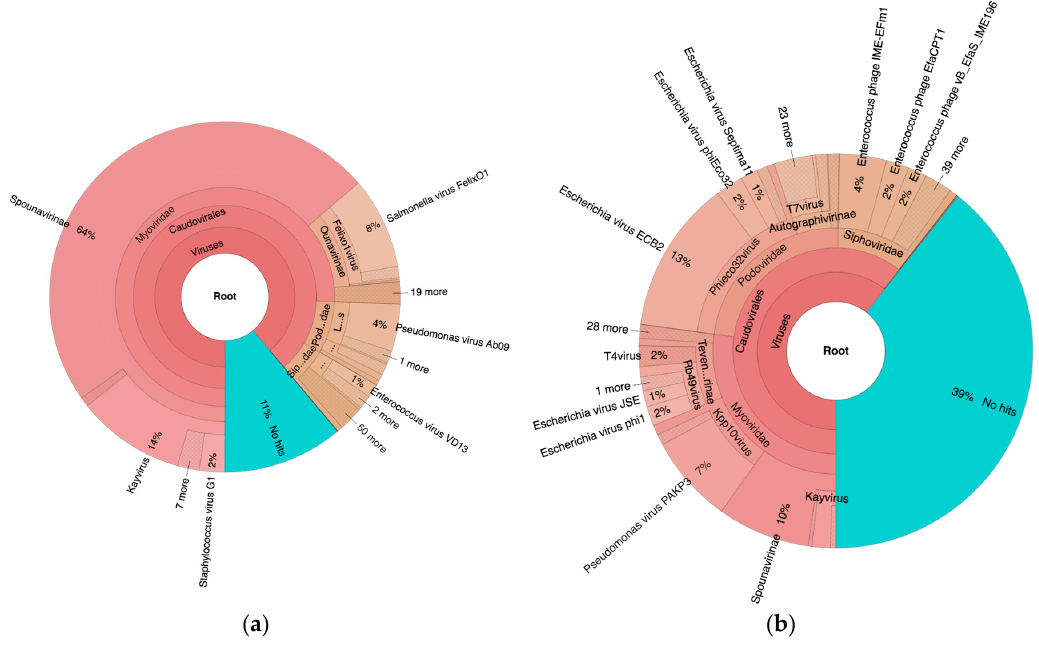
Figure 2. Krona map based on reads from PYO97 ( a ) and PYO2014 ( b ) mapped to the Kraken